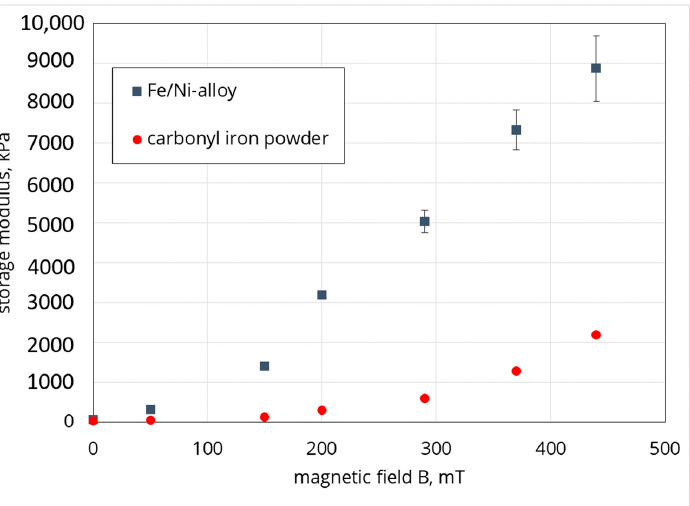
Figure 7. Shear storage modulus of the Fe/Ni alloy and carbonyl iron-based samples as a function of magnetic field (at a strain of 0.00014).